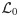
An alternating link L0 with negative writhe that is the realization of a 4 turn double crossover cube link.